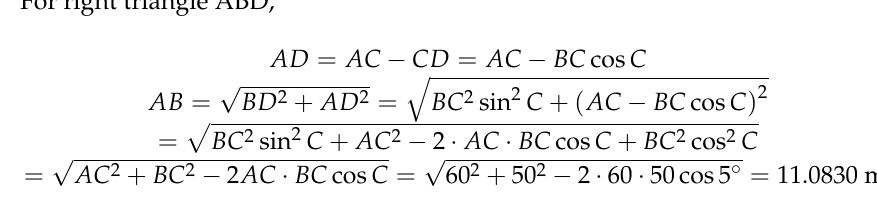
Table 5. Overall performances of students in solving the second word